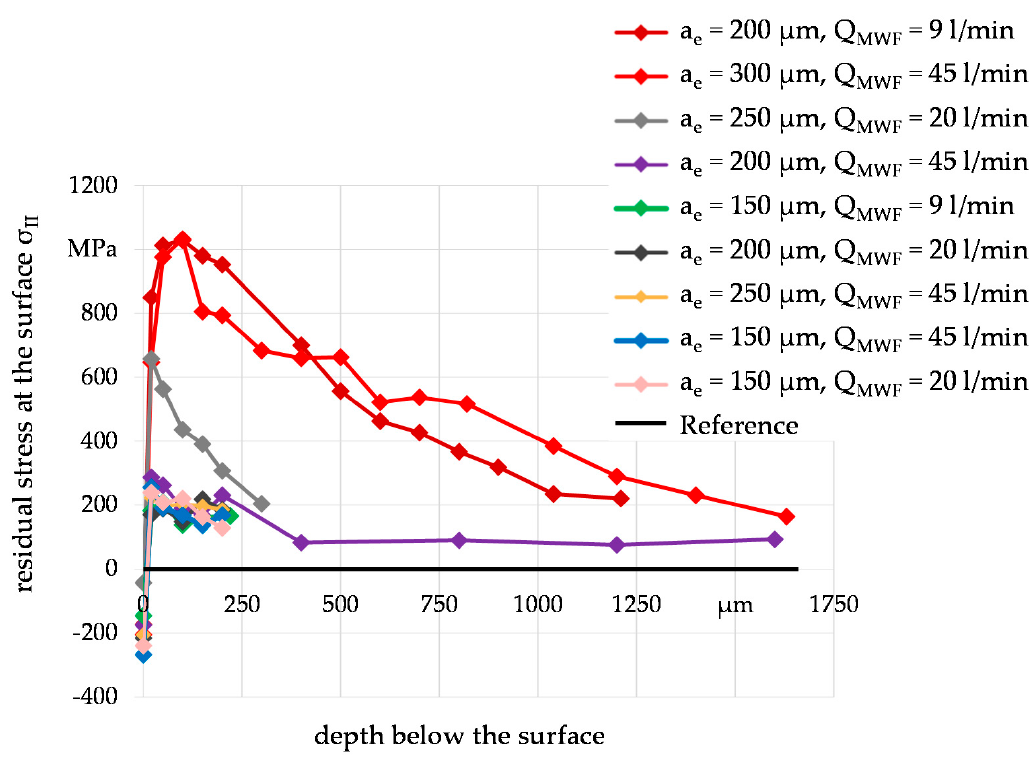
Figure 6. Residual stress depth profiles after grinding for different process parameter combina- tions